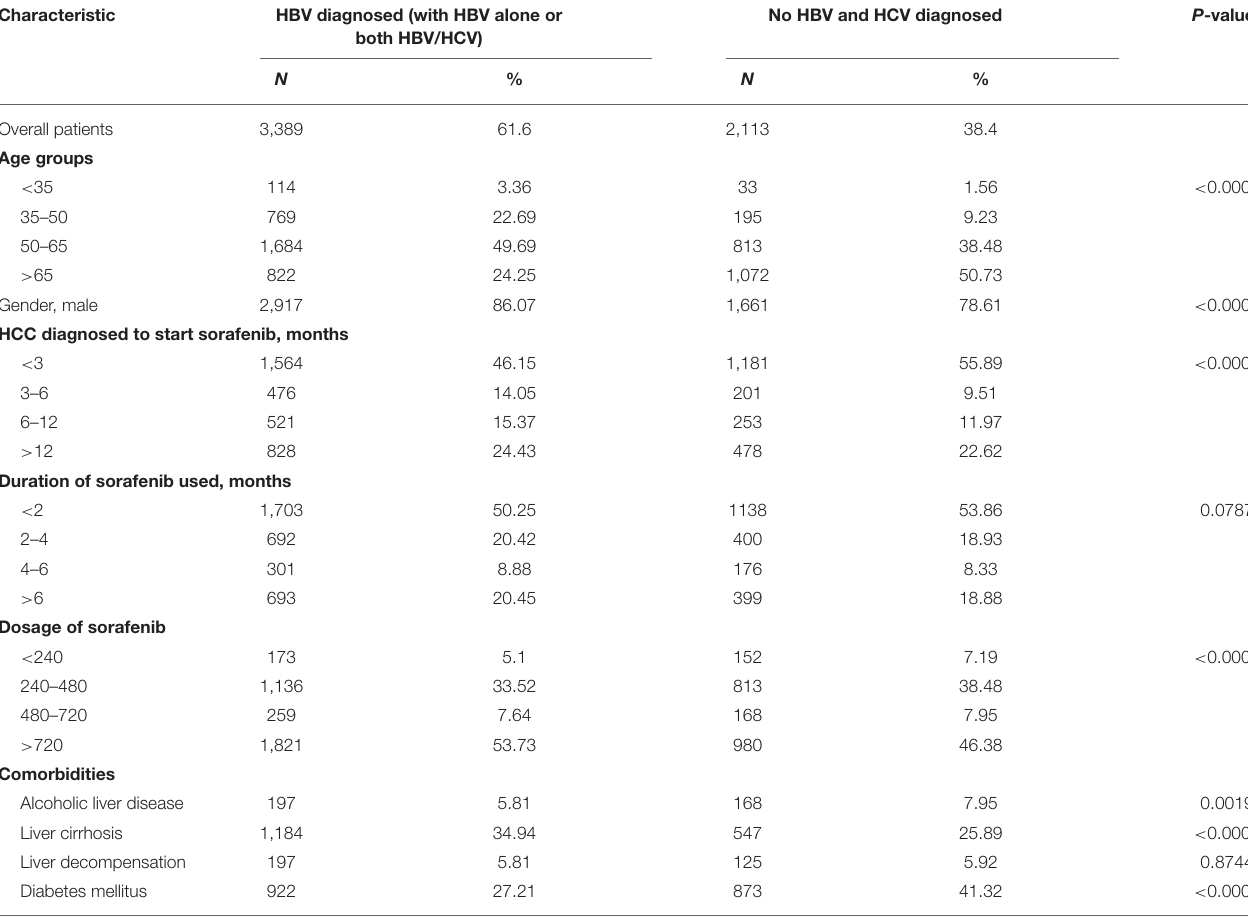
TABLE 1 | Clinical information of HCC patients treated with sorafenib with or without HBV/HCV. Characteristic